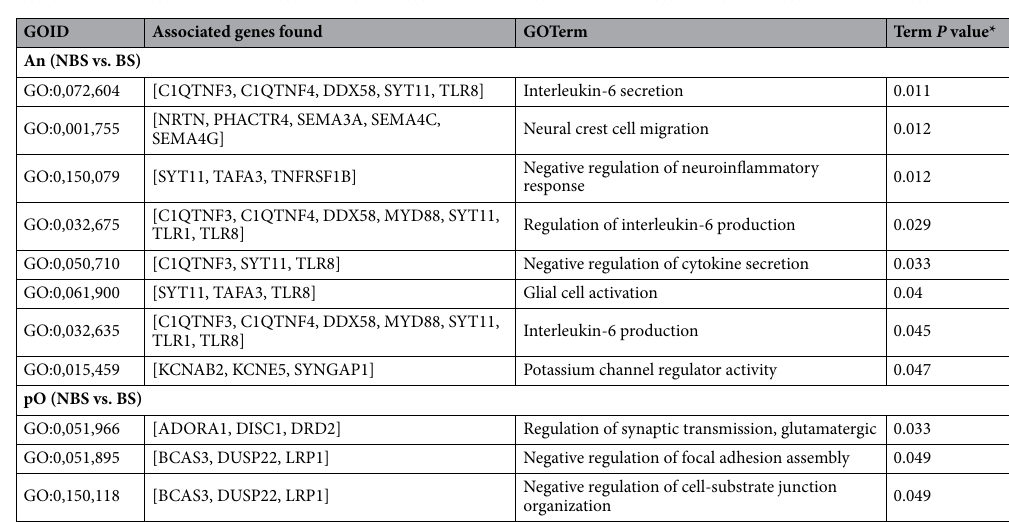
Figure 3. Average expression of differentially expressed miRNAs (DE-miRNAs) differing between non- breeding season (NBS) and breeding season (BS) in ( A ) antral follicles and ( B ) pO follicles. For each combination An and pO follicles in NBS and BS, the Log normalized miRNAs count was reported.